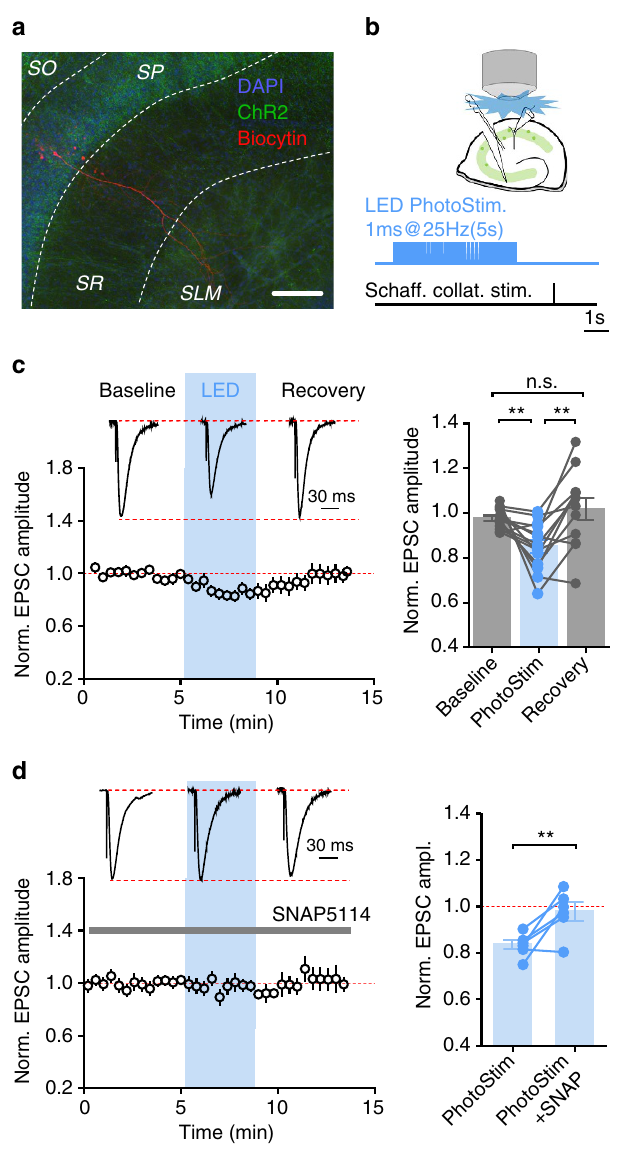
Figure 3 | Interneuronal activity suppresses glutamatergic neurotransmission via a GAT-dependent mechanism. ( a ) Hippocampal CA1 region of a mouse with Cre-dependent expression of the EYFP-tagged ChR2 (green) in PV þ interneurons. Pyramidal neuron filled with biocytin (red) during a whole-cell patch-clamp recording (scale bar, 100 m m). ( b ) EPSCs were evoked with or without preceding 5s train of photostimulation of PV þ interneurons. ( c ) Selective photo-activation of GABAergic interneurons transiently suppressed EPSC amplitude ( n ¼ 14 cells from 9 animals; left: time course; inset: representative, normalized sample traces; right: summary plot with individual data points). ( d ) SNAP5114 prevents photostimulation-induced EPSC depression ( n ¼ 6 cells from 4 animals; left: time course; inset: representative, normalized sample traces; right: summary plot with individual data points). Error bars represent s.e.m.’s, ** P o 0.02 (paired t -test);